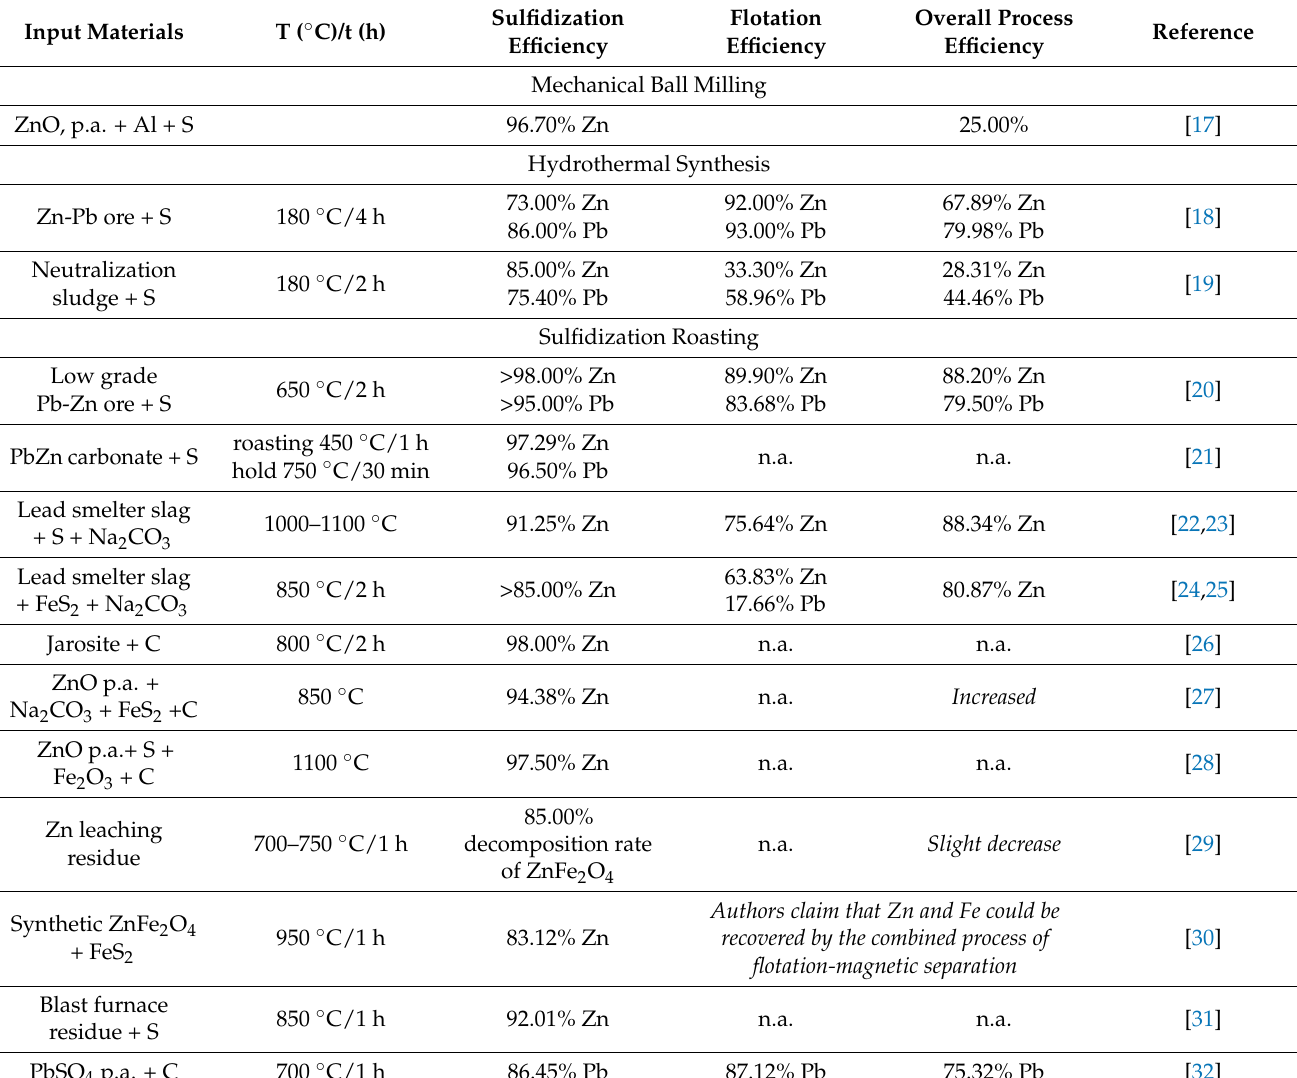
Table 1. Summary of reviewed previous studies (p.a., pro analysis; n.a., not